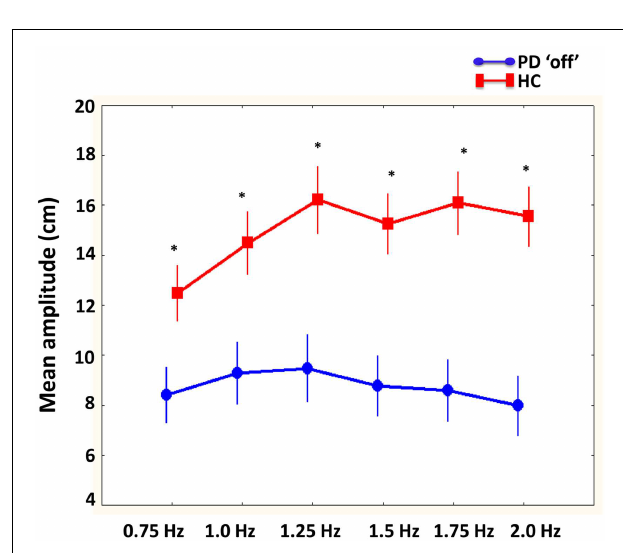
FIGURE 4 | Mean amplitude (cm) of limb movements compared between PD “off” and healthy comparison (HC) participants as a function of cycle frequencies . Results showed that larger movement were produced by HC participants compared to PD “off” at all cycle